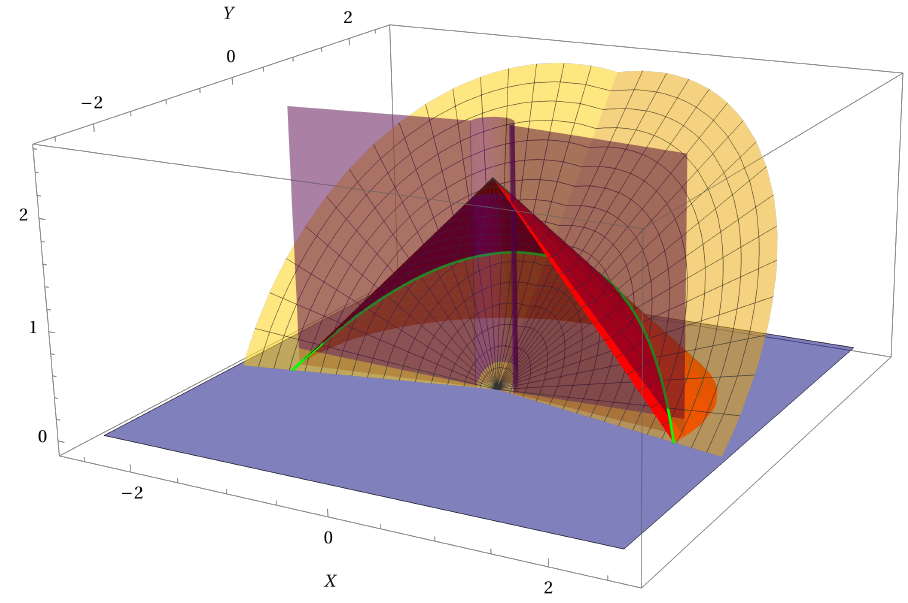
( µ ) between them (green). int